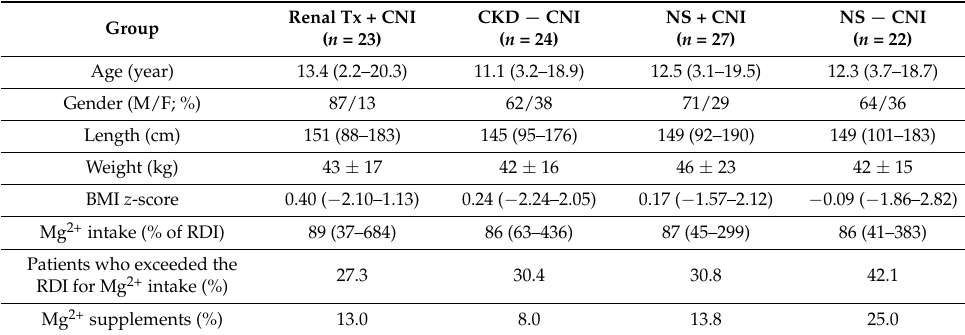
Table 1. Demographic data of the study